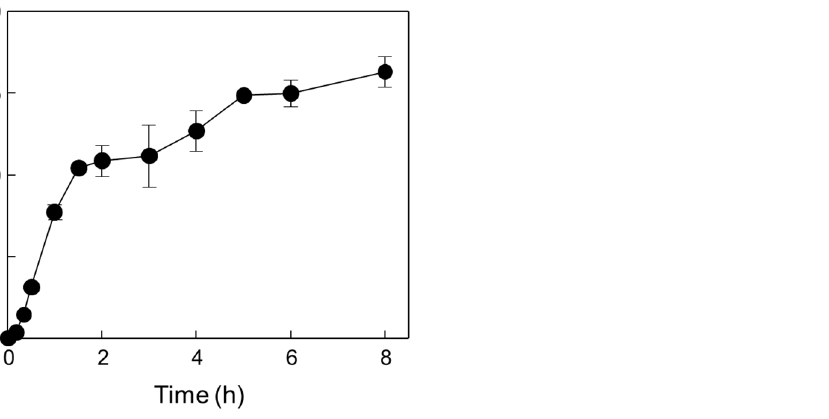
optimized reaction conditions. Time-course reactions were performed in 20 mM Kpi buffer (pH 7.4)